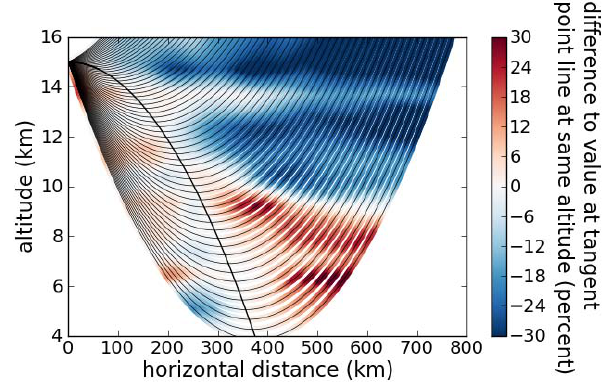
Fig. 14. Depicted are the rays of an exemplary 1-D retrieval. The ozone values are depicted relative to the value at the line of tangent points. The tangent points are shown as bold line starting from the instrument to the left and arcing down towards the